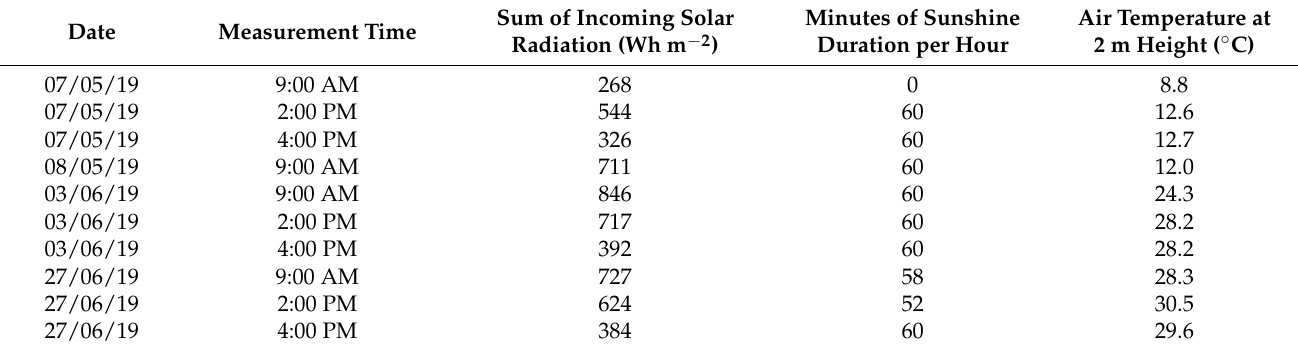
Table 1. Meteorological measurement conditions: sum of incoming solar radiation per hour, minutes of sunshine duration per hour, and air temperature at 2 m